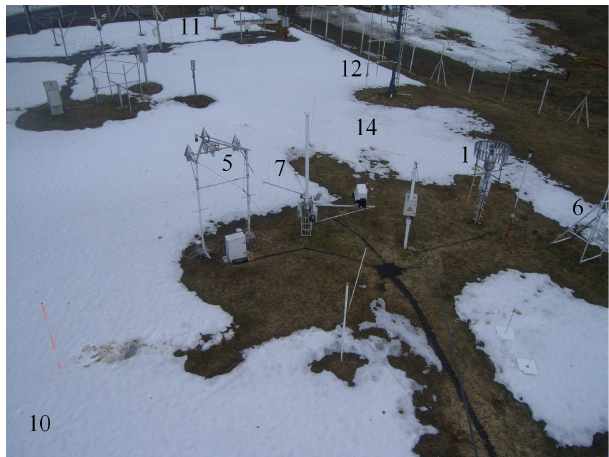
Figure 3. Overview of the experimental site near the end of the snow season (view towards the South). The numbering is similar to Fig.